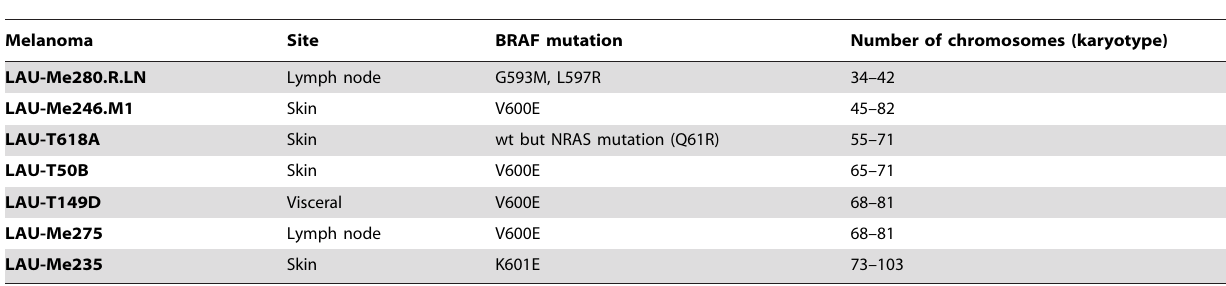
Table 1. Melanoma cell